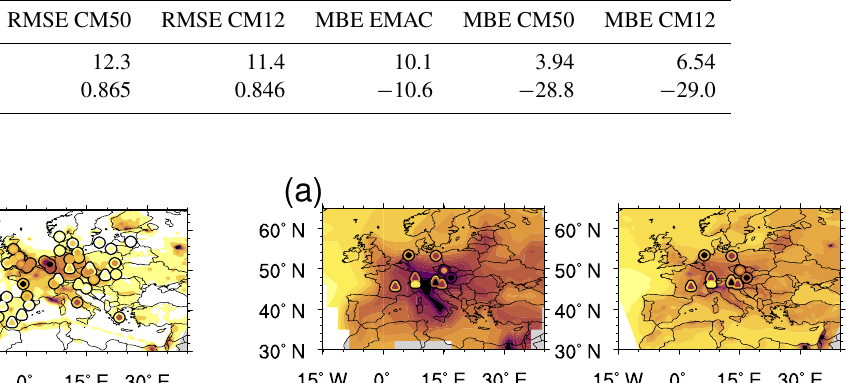
Table 3. RMSE (in µgm − 3 ) and MBE (in %) for EMAC, CM50 and CM12 in comparison to ground-level observations. Shown are the values of O 3 and NO 2 for June 2008. The values are calculated for the subset of measurement sites which are located in the CM12 domain and from the monthly averaged values for all stations with observations for the selected variable.